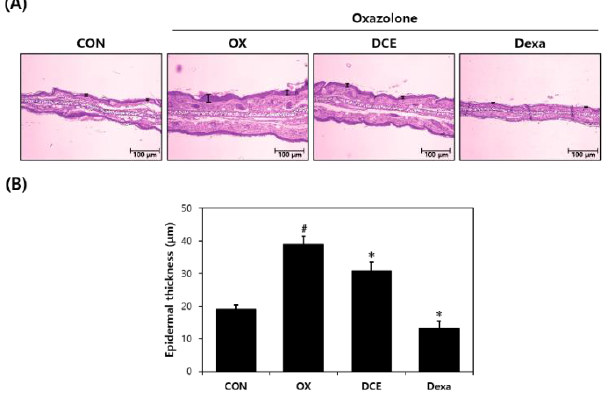
Figure 2. Effect of D. costaricensis EtOH extract (DCE) on H&E findings and epidermal thickness. ( A ) H&E staining results. ( B ) Epidermal thicknesses of mouse ears. CON group: vehicle controls, OX group: oxazolone-treated controls, DCE group: oxazolone plus 1% DCE-treated, and Dexa group: oxazolone plus 0.1% dexamethasone-treated. Data values are expressed as the means ± SEMs. # p < 0.05 vs. the CON group, * p < 0.05 vs. the OX